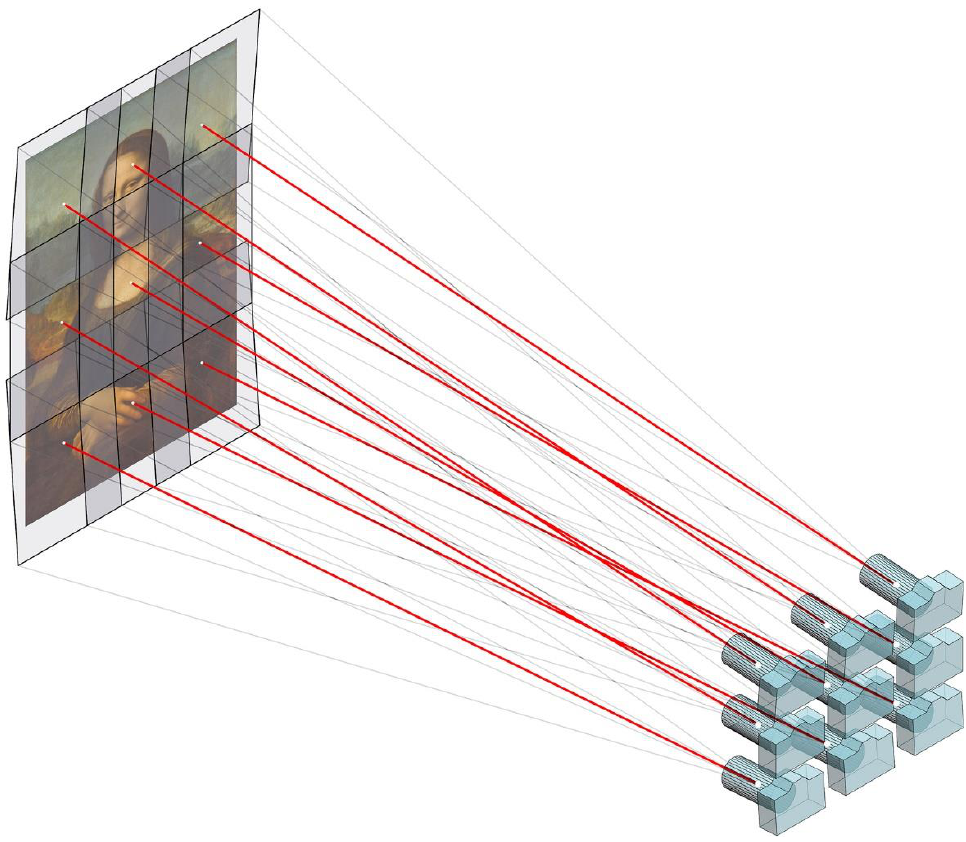
Figure 8. Tilted-multi-viewpoint capture technique. The camera is moved mostly parallel to the canvas and can be tilted if needed. Normally, only the upper or lower rows would be tilted.